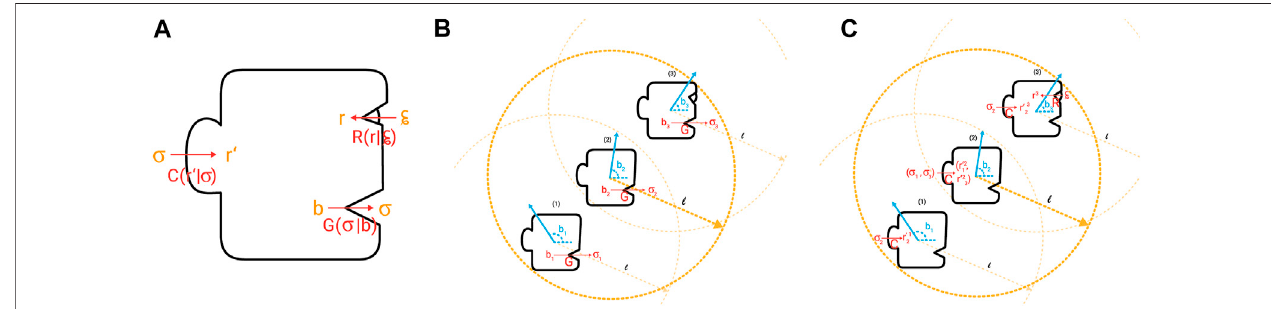
FIGURE 1 | Schematic representation of the model. (A) : Each agent is equipped with two information channels to communicate. Production channel G ( σ | b ) is used for signal production, such that signal σ is produced for a direction b with probability G ( σ | b ) . In the same way, the Comprehension channel C ( r ′ | σ ) , is used for comprehension of the signals. In addition to these, a fraction q of the individuals are informed individuals, who are equipped with an observation channel R ( r | ϵ ) . (B) and (C) : The dynamics of the model. Agents move on a two-dimensional space with constant speed v 0 and towards different directions b i . In each time step, each agent i produces a signal σ i based on its direction b i to communicate its direction of motion (B) . The signal travels up to a distance l , such that all the agents up to a distance l from a transmitter receive its signal. Receivers comprehend signals using their comprehension channel (C) . Here, agents one and three receive a signal only from agent 2, but agent 2, having two individuals in its l -neighborhood, receive signals from both one and3. Besides, agent 3, who is an informed individual, makes an observation using its observation channel. Each agent i ,makes adecision based on the information they receive from communication r ′ i , and the result ofobservation r i ) ) , r ′ 3 (cid:2) ( r ′ 3 (in the case of informed individuals), using the weighted averaging rule Eq. 1 . Here, r ′ 1 (cid:2) ( r ′ 1 2 ) , r ′ 2 (cid:2) ( r ′ 2 1 , r ′ 2 3 2